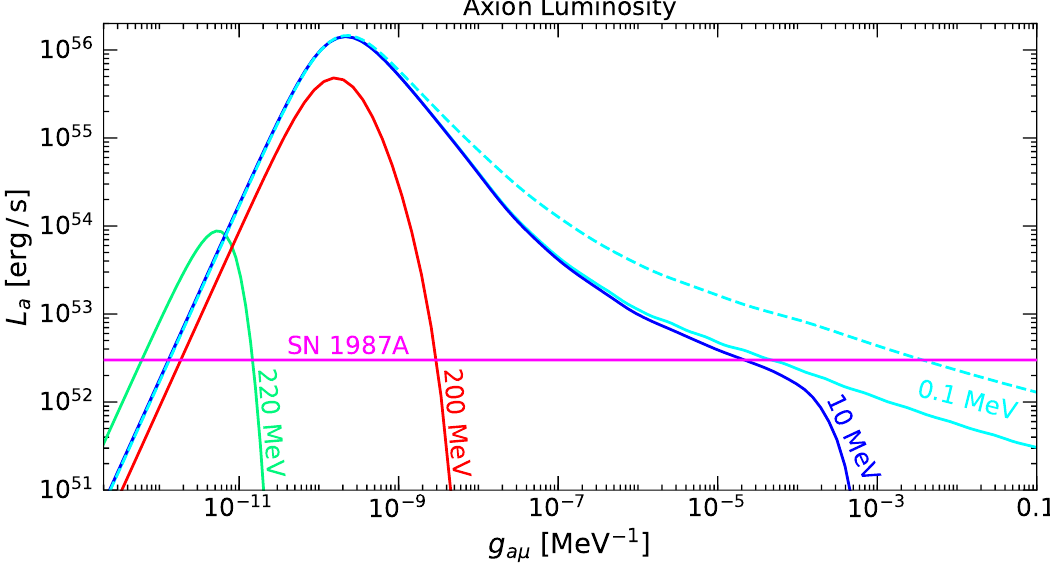
Figure 7. Luminosity due to a production in the PNS using the SFHo20.0 simulation as a function of the coupling g aµ for four choices of m a , found using eqs. (3.3) and (3.4) with the rates described in section 5.2. The flat line gives the value L ν defined in eq. (3.5). The dashed line shows the effect of taking R far → R ν in eqs. (3.3) and (3.4).